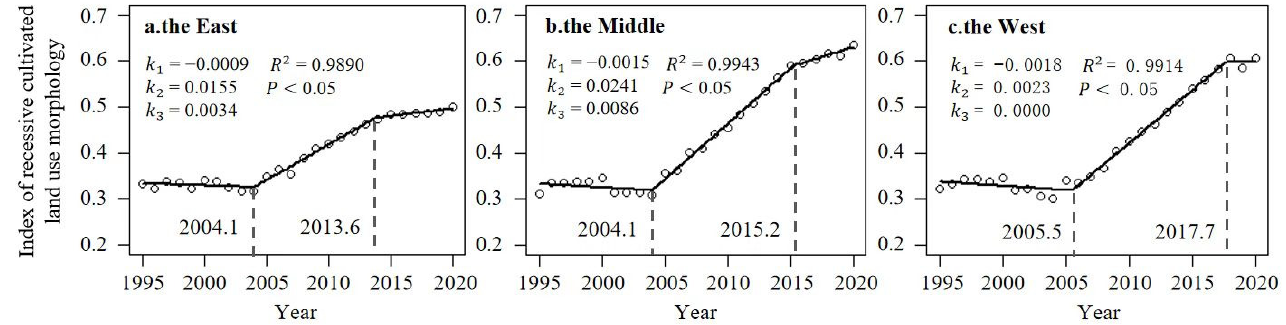
Figure 6. Mutant point detection of the recessive index concerning the eastern, middle, and western parts of the Huaibei region of the Jiangsu province between 1995 and 2020.